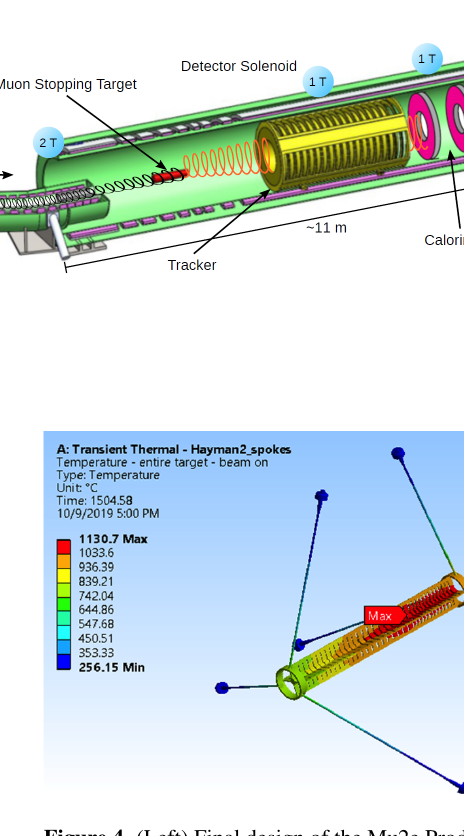
Figure 4. (Left) Final design of the Mu2e Production Target.